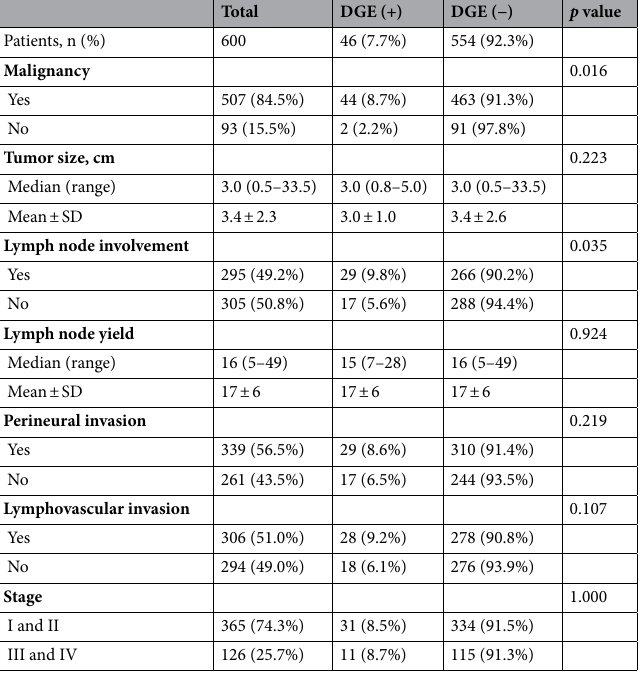
Table 2. Histopathological factors for DGE after pancreaticoduodenectomy. DGE delayed gastric emptying, SD standard deviation.